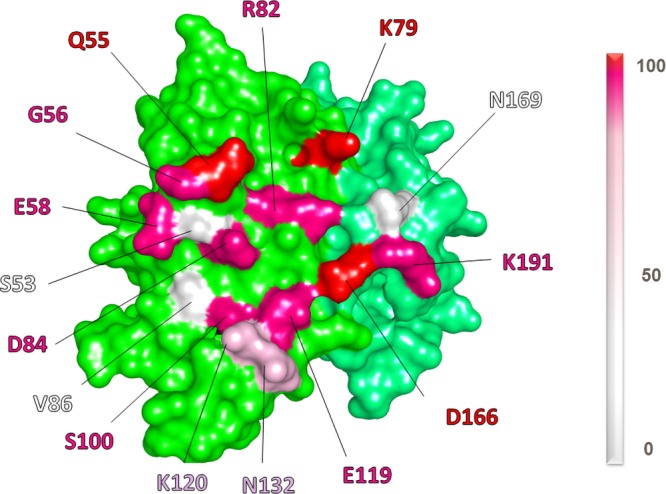
Allelic conservation of the key residues of fHbp v3 involved in the interaction with Fab 1E6. The figure shows fHbp v3 as solid surface. Each residue of the epitope is colored based on its conservation among the fHbp gene repertoire, which included 1119 allelic sequences.